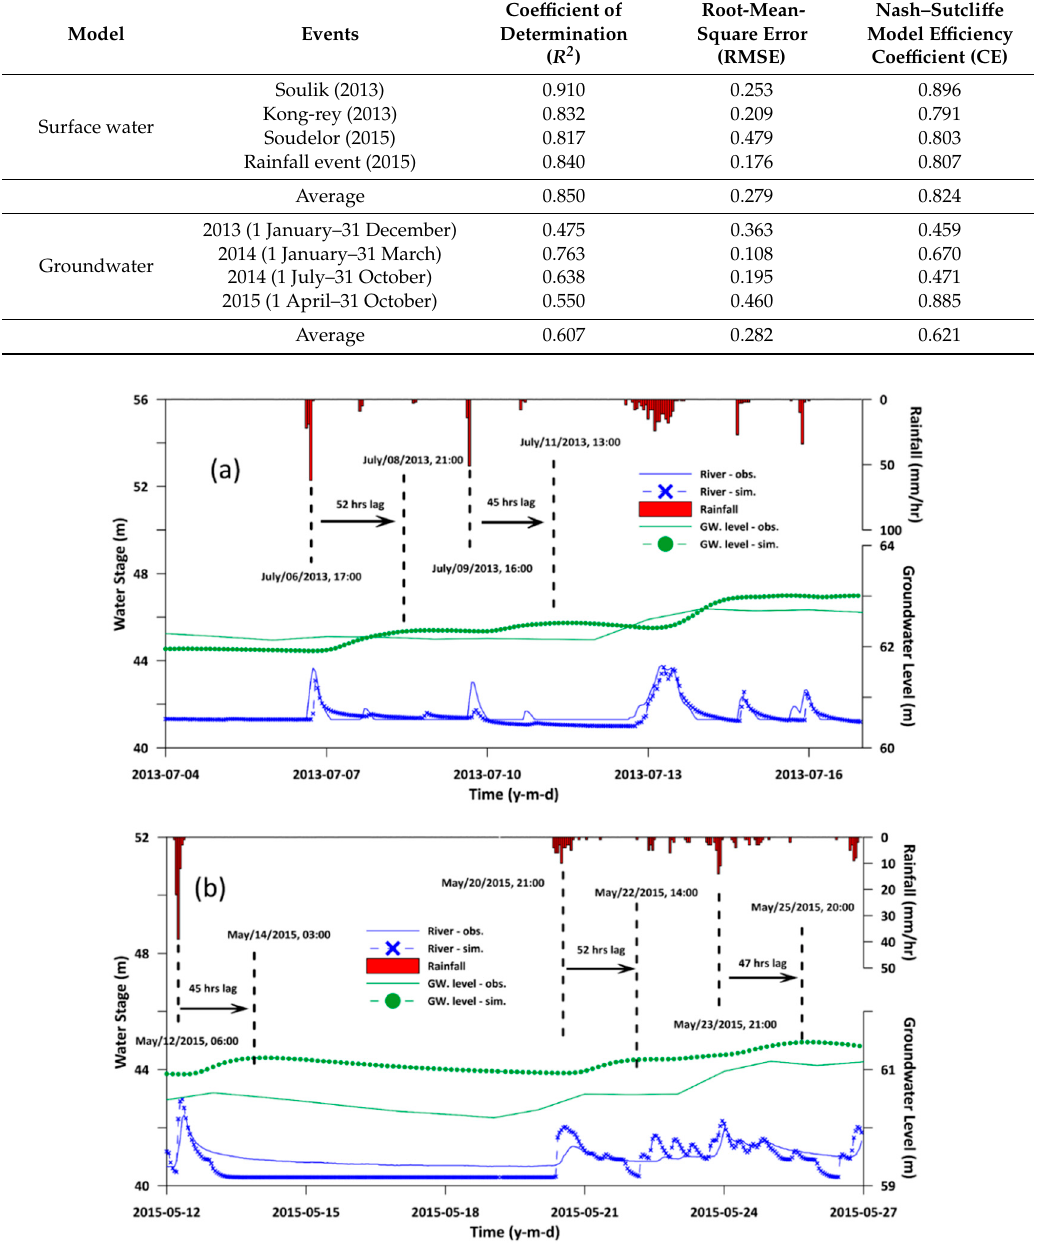
Figure 5. Rainfall-induced flow patterns of surface water and groundwater during ( a ) 4 July to 17 July of 2013, and ( b ) 12 May to 27 May of 2015.